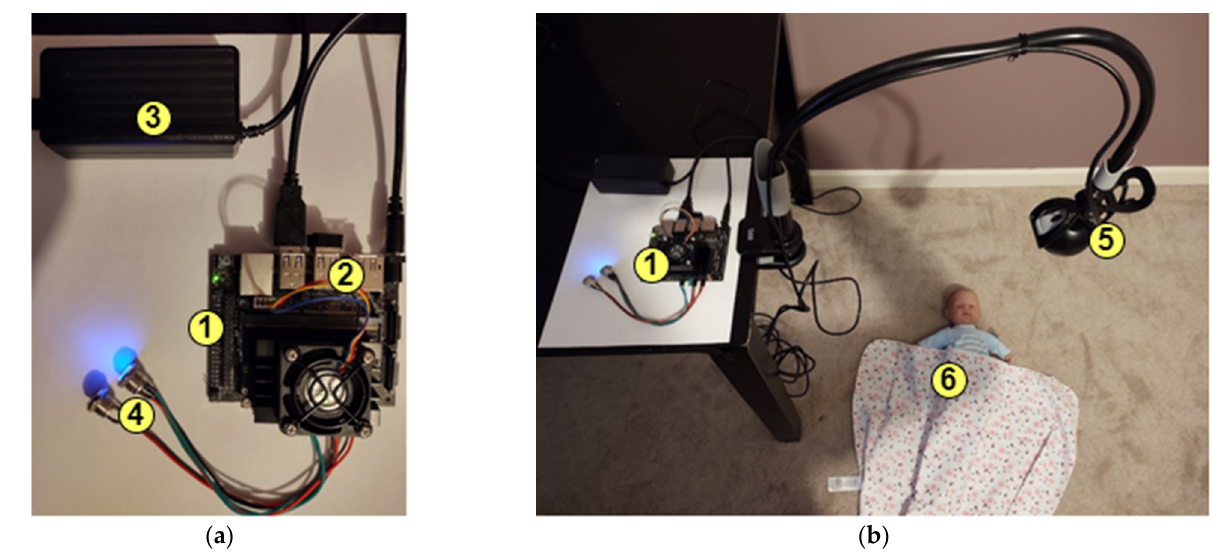
Figure 13. Photograph of the smart baby monitor device: ( a ) closeup view of the device–(1) Jetson Nano microcontroller board, (2) USB Wi-Fi dongle, (3) DC power adaptor, (4) power and reset switches; ( b ) birds eye view of the setup–(5) camera with night vision capability, (6) doll with blanket.